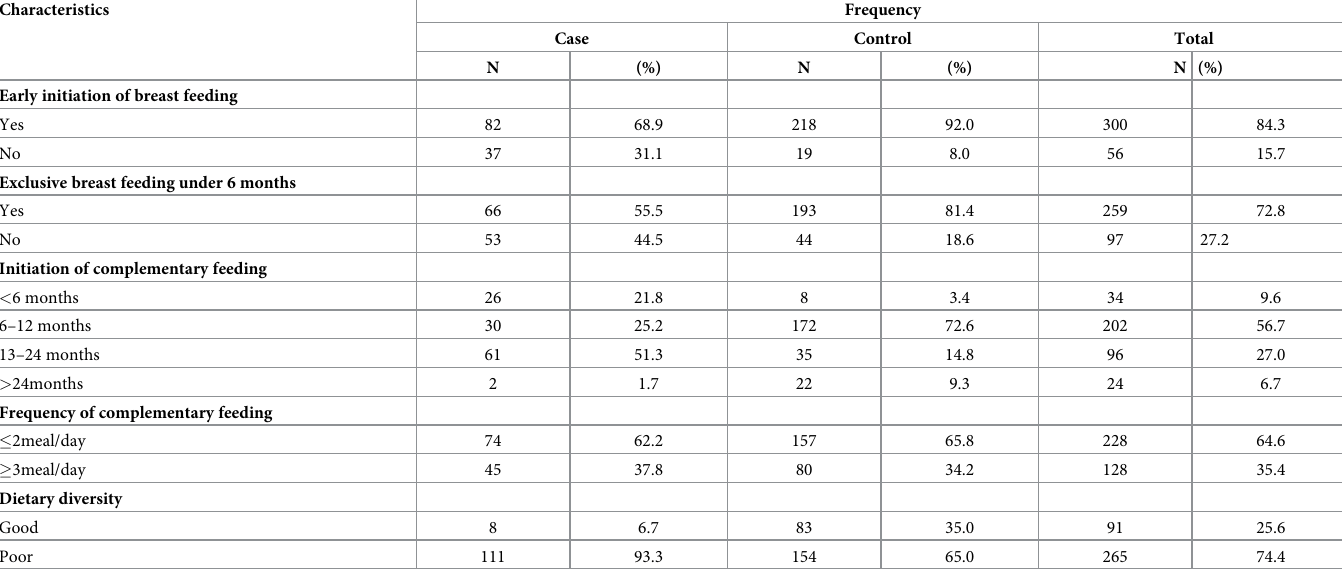
Table 2. Child caring practice characteristics among children aged 6–59 months in Wonago Woreda, South Ethiopia November